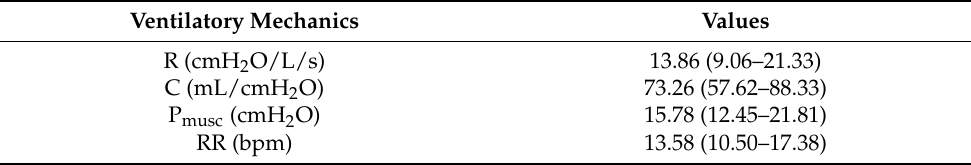
Table 1. Median and interquartile ranges of ventilatory mechanics data for obstructive DB.